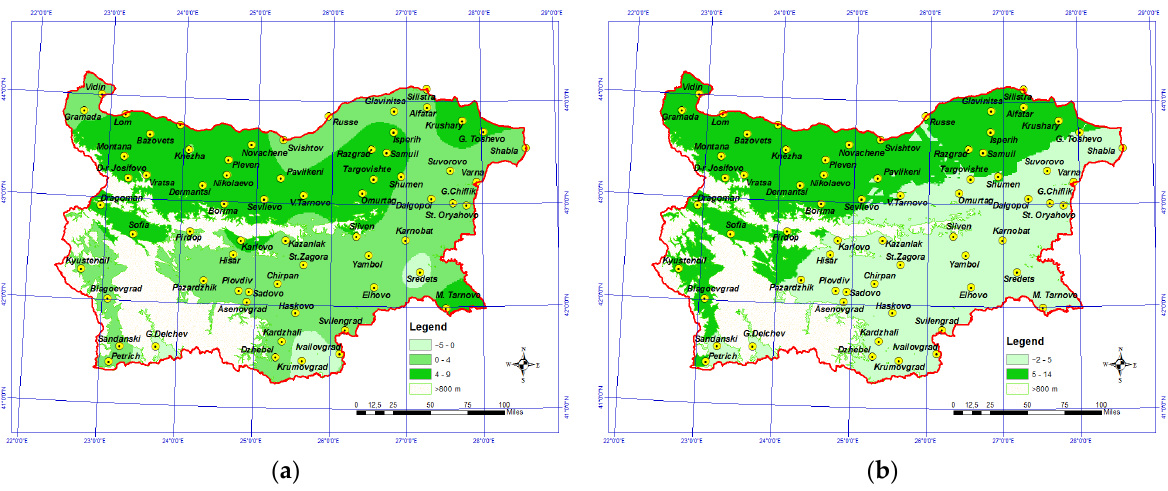
Figure 6. Deviations in the duration of the period with temperatures above 5 °C ( a ) and 10 °C ( b